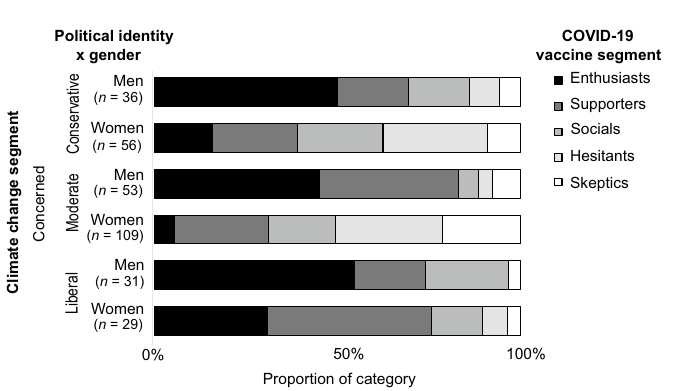
Figure 4. Vaccine segment distributions within the Concerned climate segment for men and women with conservative, moderate, and liberal political